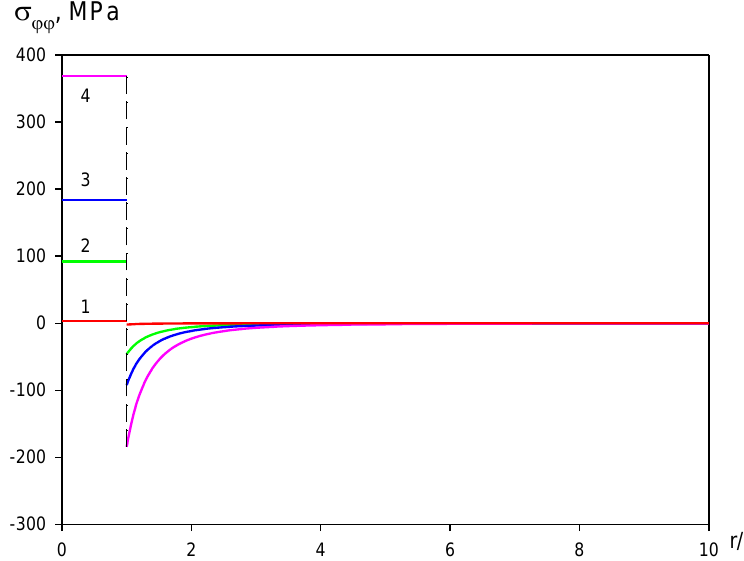
Figure 7. The distribution of the tangential stresses σ rr in the particle and matrix for various values of the temperature difference: 1 —Δ T = 10 K; 2 — 50 K; 3 — 100 K; 4 — 200 K.